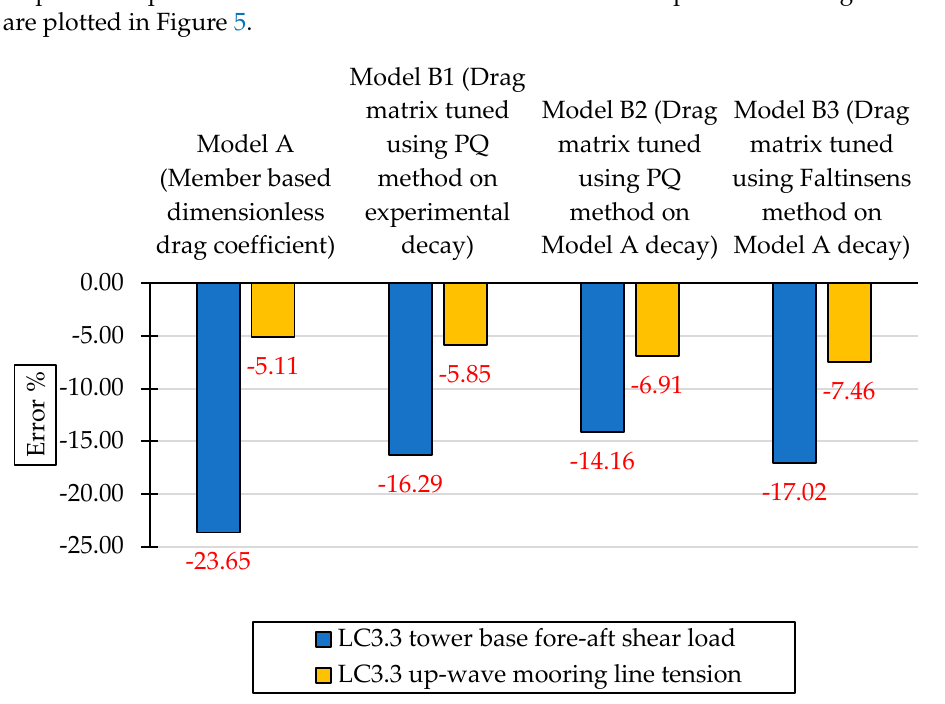
Figure 5. LC3.3, 95-percentile peak load error % of the numerical models compared to the experi- ment.